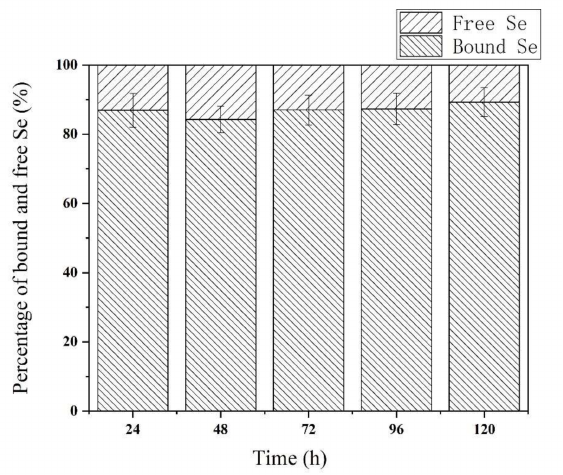
Figure 3. The percentage of bound Se and free Se during soybean germination under 20 mg/L sodium selenite